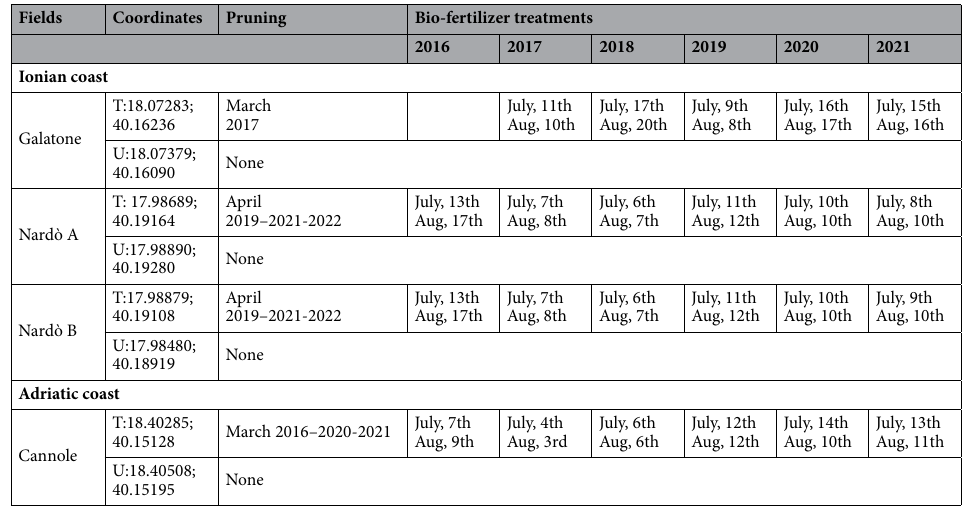
Table 1. Experimental treated (T) and untreated (U) fields with pruning and treatment dates. Only July and August treatments reported.